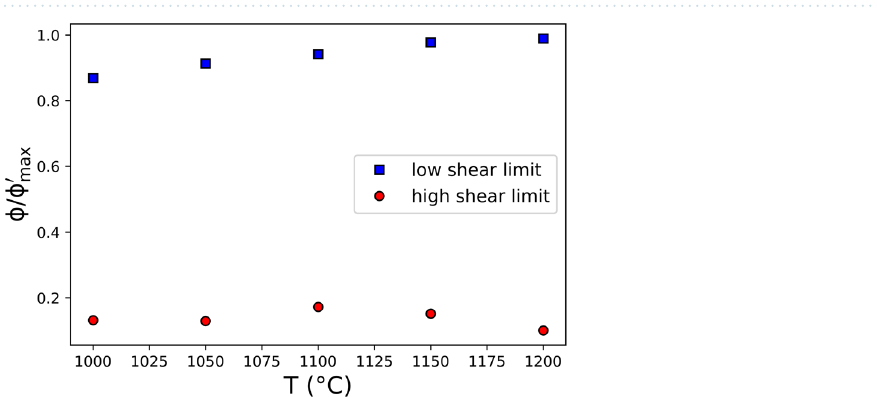
Figure 4. The effective particle cluster volume fraction in the low shear rate regime (blue squares) along with the effective particle cluster volume fraction in the high shear rate regime (red circles). The maximum packing fraction for low and high shear scenarios are displayed as dotted lines of their respectively